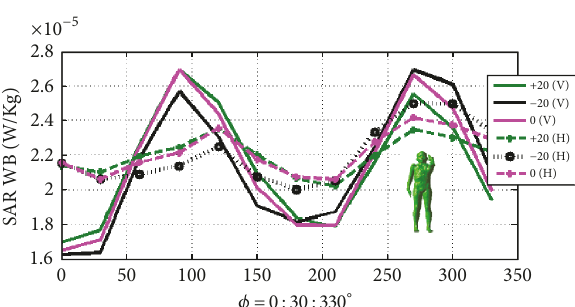
Figure 11: Variation of SAR obtained with the posture voice- WB standing-900 MHz after an exposure to a plane wave coming from three elevations, from azimuth from 0 to 360 and in both V- Figure 13: Comparison between the SAR polarization and H-polarization. data configurations (standing and sitting postures) at 900 MHz and 1940 MHz, respectively. Results obtained after an exposure to plane wave vertically polarized at zero